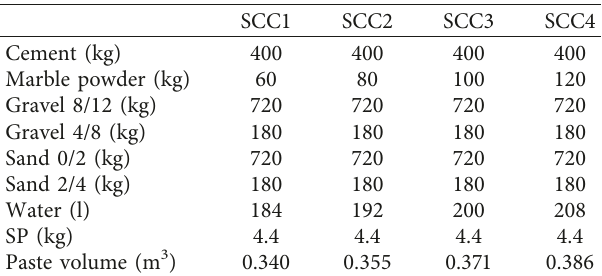
Table 6: Composition of the different